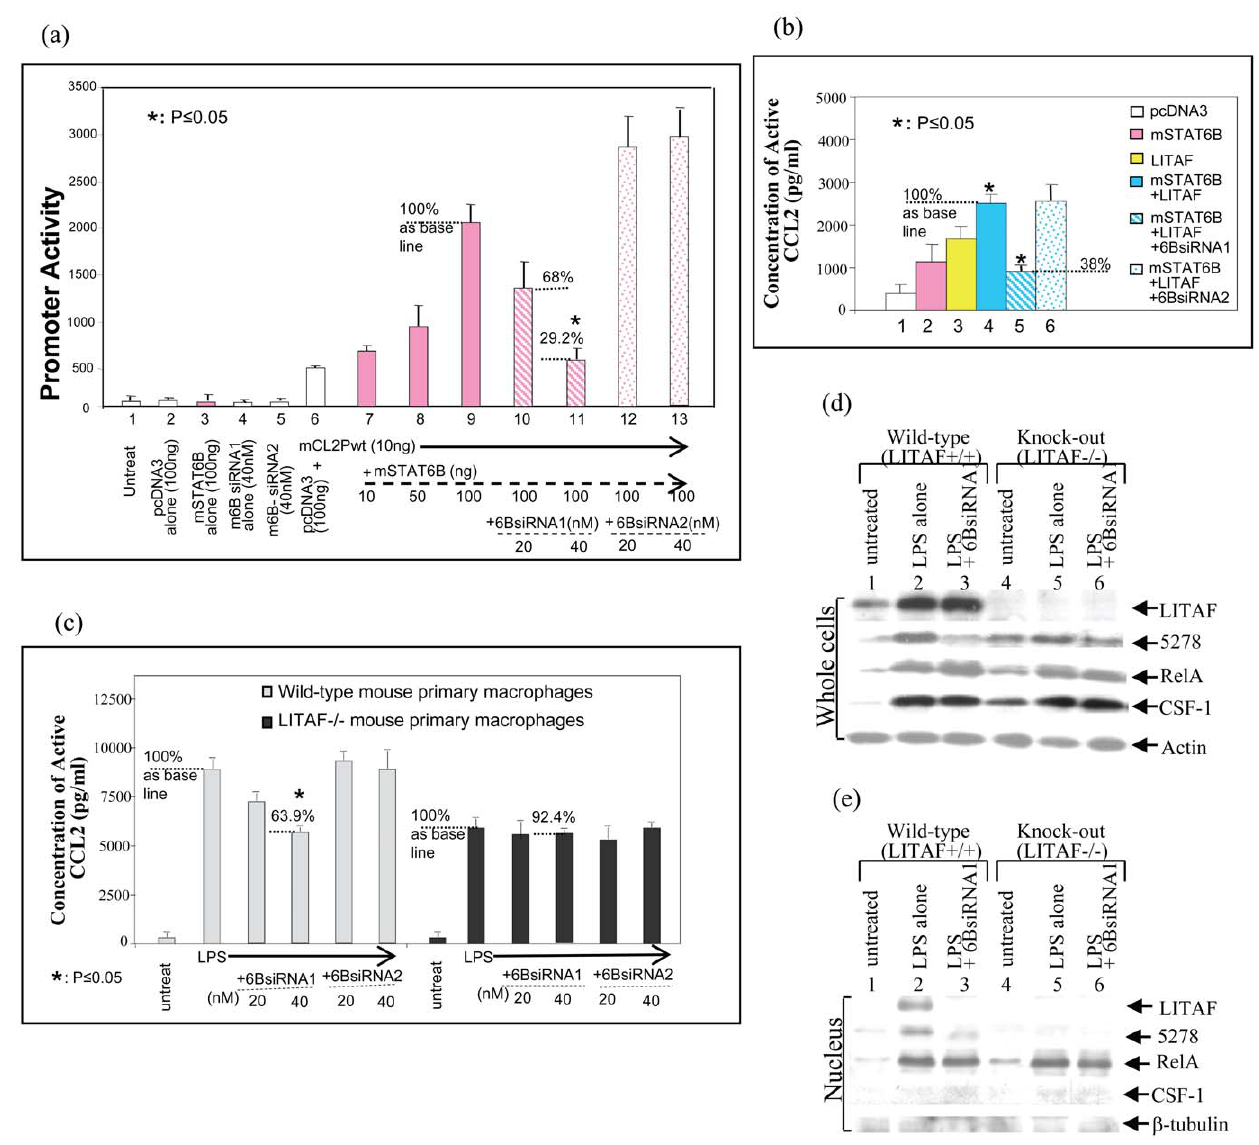
Figure 4. Downregulation of CCL2 gene transcription by 6BsiRNA1 silencing of mSTAT6B. (a) Downregulation of CCL2 promoter activity by 6BsiRNA1. Raw264.7 cells were untreated (No. 1) or transfected with pcDNA3 alone as control (No. 2), mSTAT6B DNA alone (No. 3), 40 nM m6BsiRNA1 alone (No. 4), 40 nM m6BsiRNA2 alone (No. 5), or cotransfected with mCL2Pwt (No. 6-13) plus pcDNA3 (No. 6), or plus different concentration of mSTAT6B DNA (No. 7-13). All experimental groups were cotranfsected with 5 ng of b -gal DNA. Treated cells were immediately added with 6BsiRNA1 (No. 4, 10&11) or 6BsiRNA2 as the negative control (No. 5, 12&13) and cultured overnight. The cell lysate from each test group was used for luciferase assay. Triplicate assays were performed and their values were normalized according to b -gal production and graphed. (b) Regulation of CCL2 gene expression by 6BsiRNA1. Raw264.7 cells were transfected with 100 ng pcDNA3 alone as control (white bars), 100 ng mSTAT6B DNA alone (pink bars), 100 ng mLITAF DNA alone (yellow bars) or cotransfection with both 100 ng mLITAF and 100 ng mSTAT6B DNAs (blue bars) plus 40 nM 6BsiRNA1 (striped blue bars) or plus 40 nM 6BsiRNA2 as control (dotted blue bars). All test cells were cotransfected with 5 ng of b -gal DNA. Treated cells were cultured overnight. The conditioned medium from each test group was used to detect CCL2 production by ELISA. Triplicate assays were performed and their values were normalized according to b -gal production and graphed. (c) Wild-type or LITAF 2 / 2 mouse primary macrophages were untreated as control or treated with 100 ng/ml of E. coli LPS for 2 hrs and washed with PBS. The treated cells were added with different concentrations (20 or 40 nM) of 6BsiRNA1 or 6BsiRNA2 as negative control and cultured overnight. The conditioned medium from each test group was used to detect CCL2 production by ELISA and the protein concentration of the corresponding cell lysate was measured for normalization. Triplicate assays were performed and graphed. (d&e) Mouse macrophages collected from wild-type mouse (No. 1-3) or from LITAF- deficient genotype mice (No. 4-6) were treated with 0.1 m g/ml E. coli LPS (No. 2,3,5&6) or untreated as control (No. 1&4) for 2 hrs and washed with PBS. The treated cells were cultured overnight. Proteins from whole cells (panel d) or nuclei (panel e) were purified and subjected to Western blot with the antibodies against mLITAF, mSTAT6B (5287), RelA, CSF-1, or Actin as control (indicated by arrows). The assays were performed in triplicate and a representative experiment is presented.